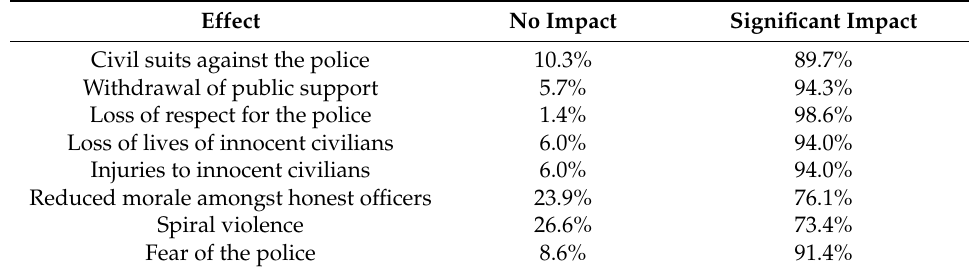
Table 1. The response on the implications of police abuse of powers and functions, N =